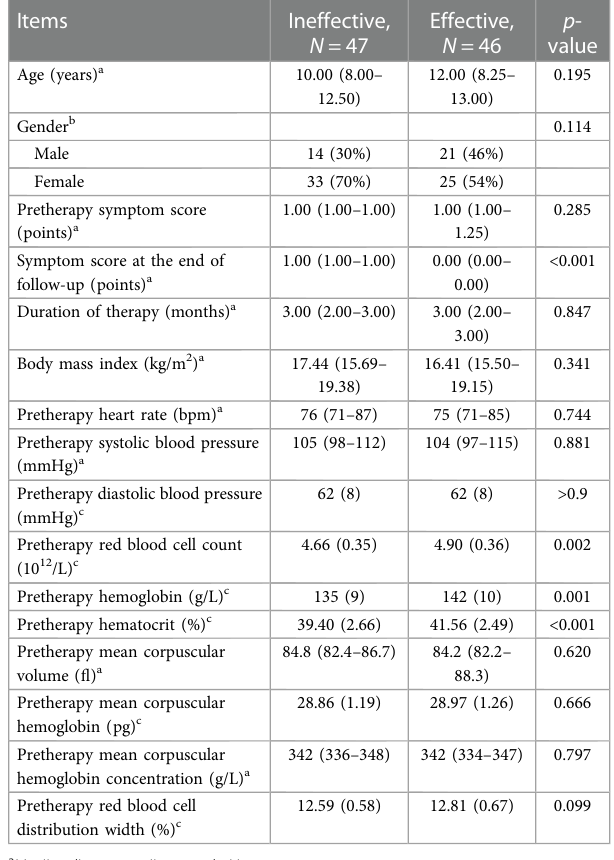
TABLE 1 Baseline demographic and clinical data between effective and ineffective groups.